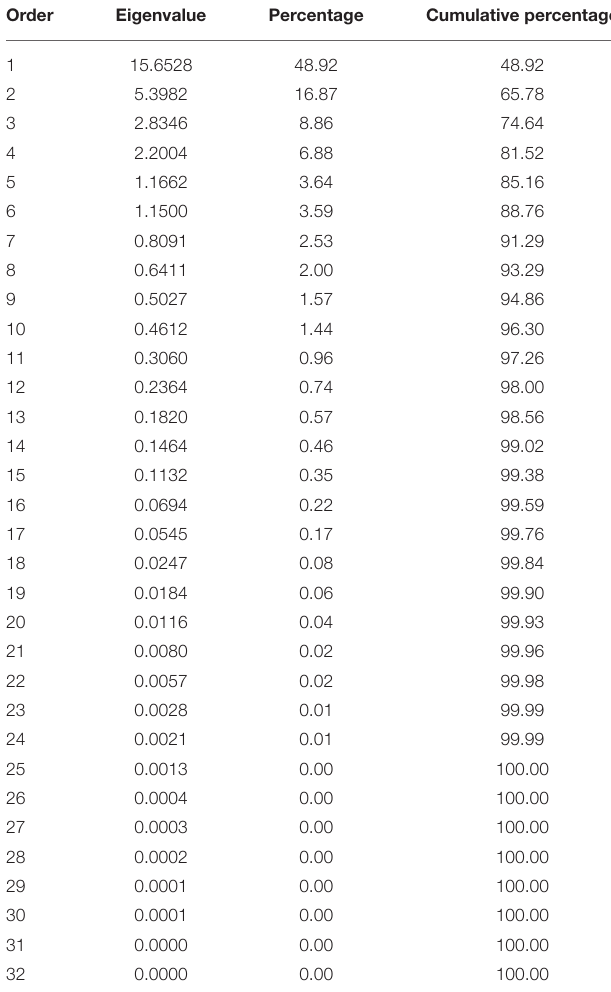
TABLE 3 | Eigenvalues of the correlation matrix from the principal component analysis of the traits evaluated in pure stands and binary mixtures of seven common bean cultivars at three Ontario environments/locations in